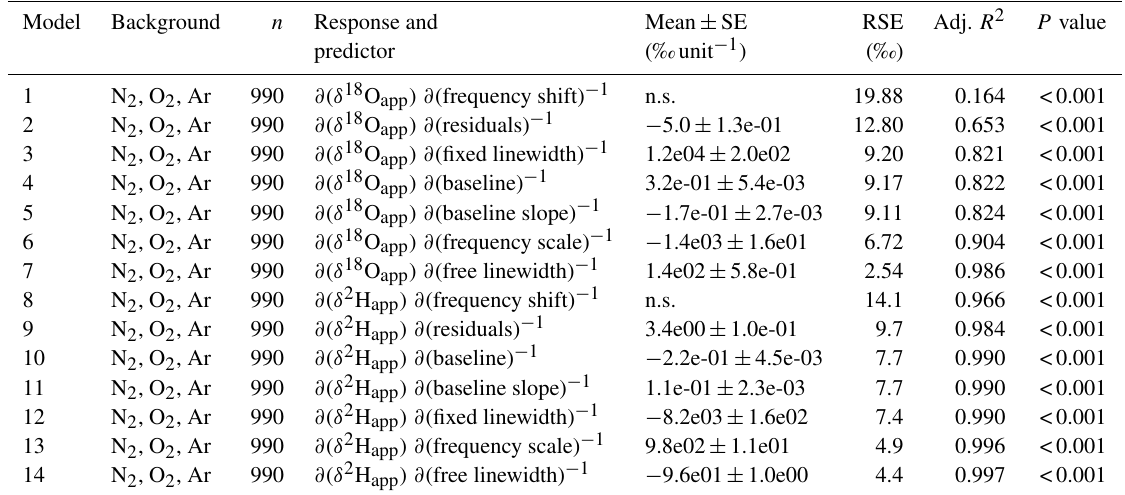
(Table 4; Model 6) and a positive sign for δ 2 H values (Ta- ble 4; Model